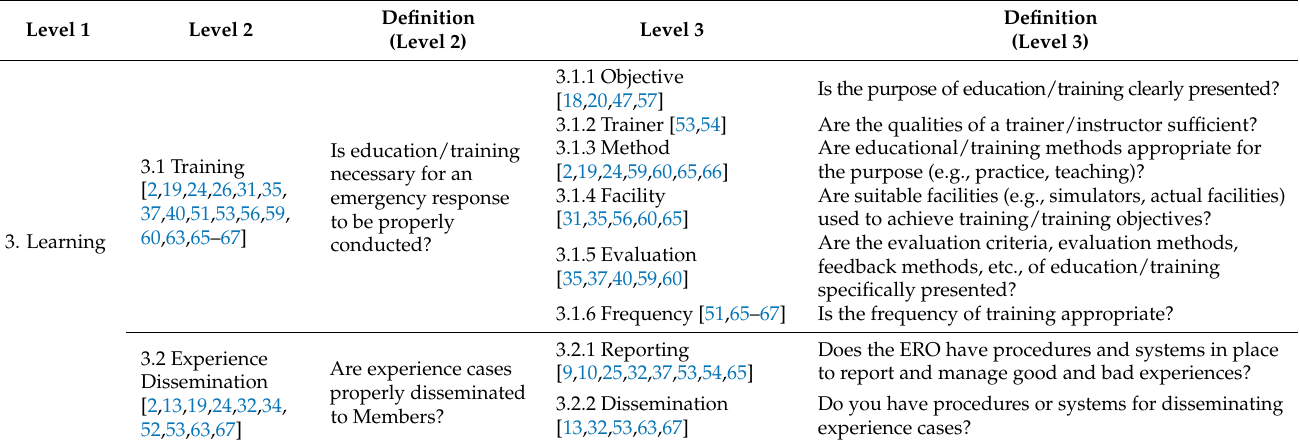
Table 10. Definitions and contributing factors for learning capability.